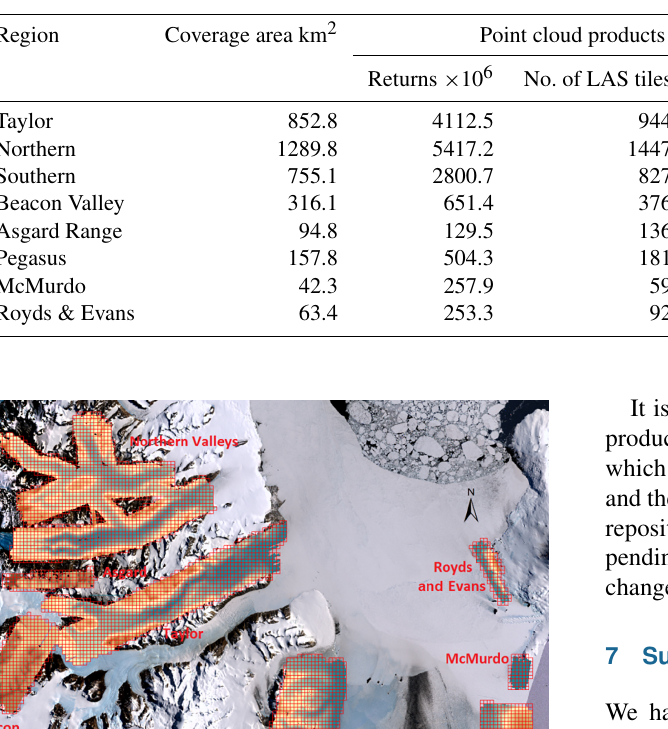
Table 1. Summary of available lidar data products. Returns are the lidar returns from the Earth’s surface; no. of LAS tiles is the number of point cloud tiles for each section; LAS Gb is the data storage size in gigabytes for the point cloud data; no. of sections is the number of individual sections that constitute the entire elevation raster for each region; DEM Gb is the data storage size in gigabytes of the digital elevation model that covers that region; SRM Gb is the data storage size in gigabytes of the shaded relief maps.